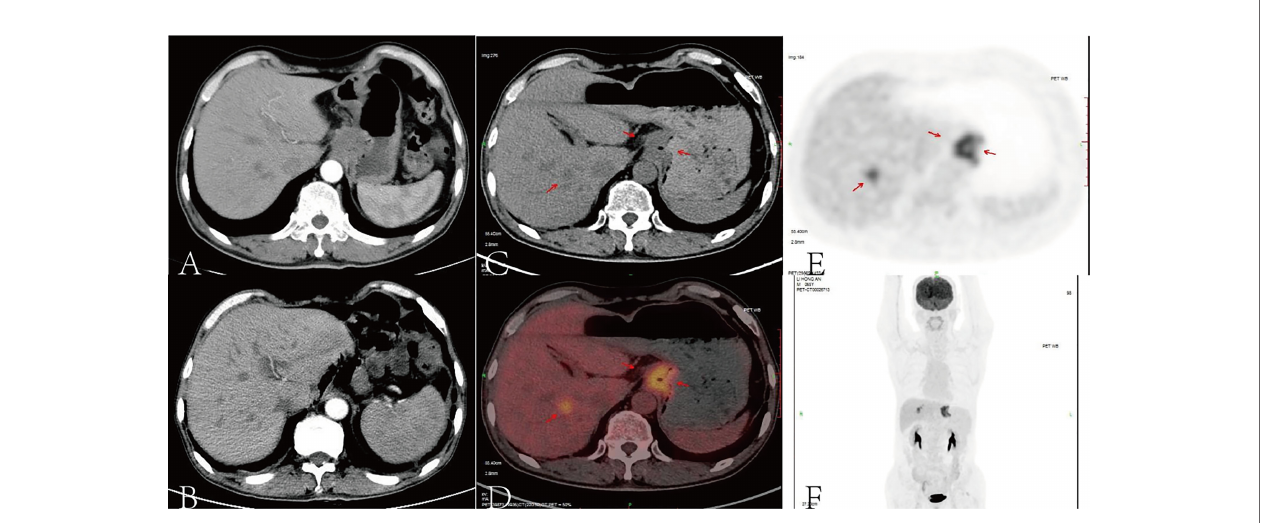
FIGURE 1 | According to an abdominal contrast-enhanced computed tomography (CT) scan, there were a malignant gastric mass and seven low-density shadows in the liver recognized as liver metastases (A) . After eight cycles of SOX, contrast-enhanced CT scan showed no recurrence of the primary tumor, but liver metastases did not show any obvious changes (B) . After surgery and chemotherapy for gastric cancer, the stomach was absent, and the lower esophagus and jejunum were anastomosed. A high-density metal anastomotic line shadow (indicated by the arrow) can be seen at the anastomotic stoma, and a small patch of slightly increased radiation uptake shadow can be seen locally. A small nodular low-density shadow with a size of about 0.5 cm can be seen in the right lobe of the liver (S8 segment). The density and radioactivity distribution in other parts of the liver were not abnormal. A small nodule-calci fi ed shadow can be seen under the capsule of the right lobe of the liver (S6 segment). According to the positron emission tomography (PET) scan, the red arrows pointed out the tumor foci (C – E) , the image (F) showed the image of coronal